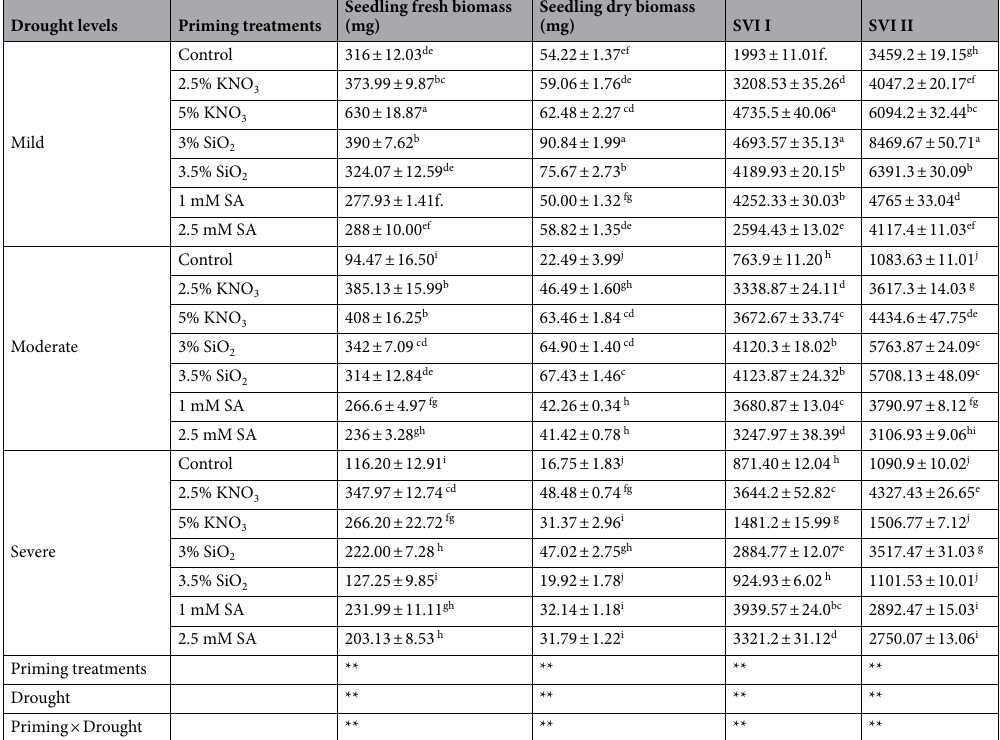
Table 3. Effects of KNO 3 , SiO 2 and SA priming on seedling biomass and vigour of rice under drought conditions. Mean values ± SE in the same column followed with similar letters are not significantly different according to DMRT ( P ≤ 0.05); SE Standard error of the mean, SVI I Seedling vigour index I, SVI II Seedling vigour index II, *Significant at 5% level of probability, **Significant at 1% level of probability, ns Not